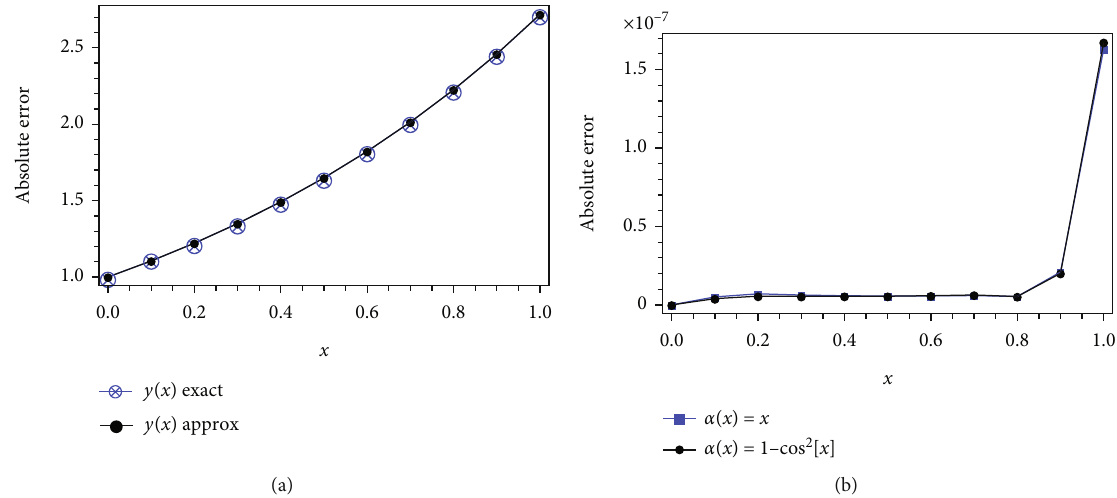
Figure 2: Exact solution and numerical solutions (a), absolute error at two di ff erent cases of α ð x Þ (b) for Example 2 of N = 7 , τ = 0 , and h = 1